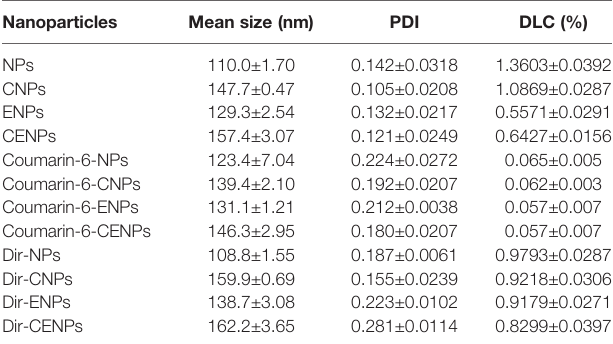
TABLE 1 | Particle size, polydispersity index (PDI), and drug loading capacity (DLC) of nanoparticles. Measured in double-distilled water (n = 3), mean ± SD.